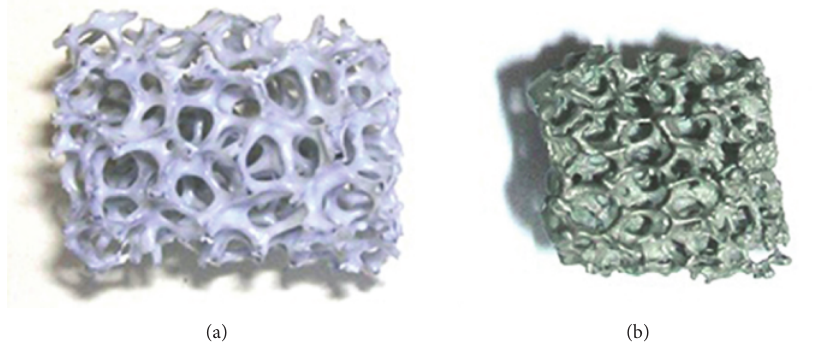
Figure 1: (a) Polyurethane foam model. (b) Produced sample.